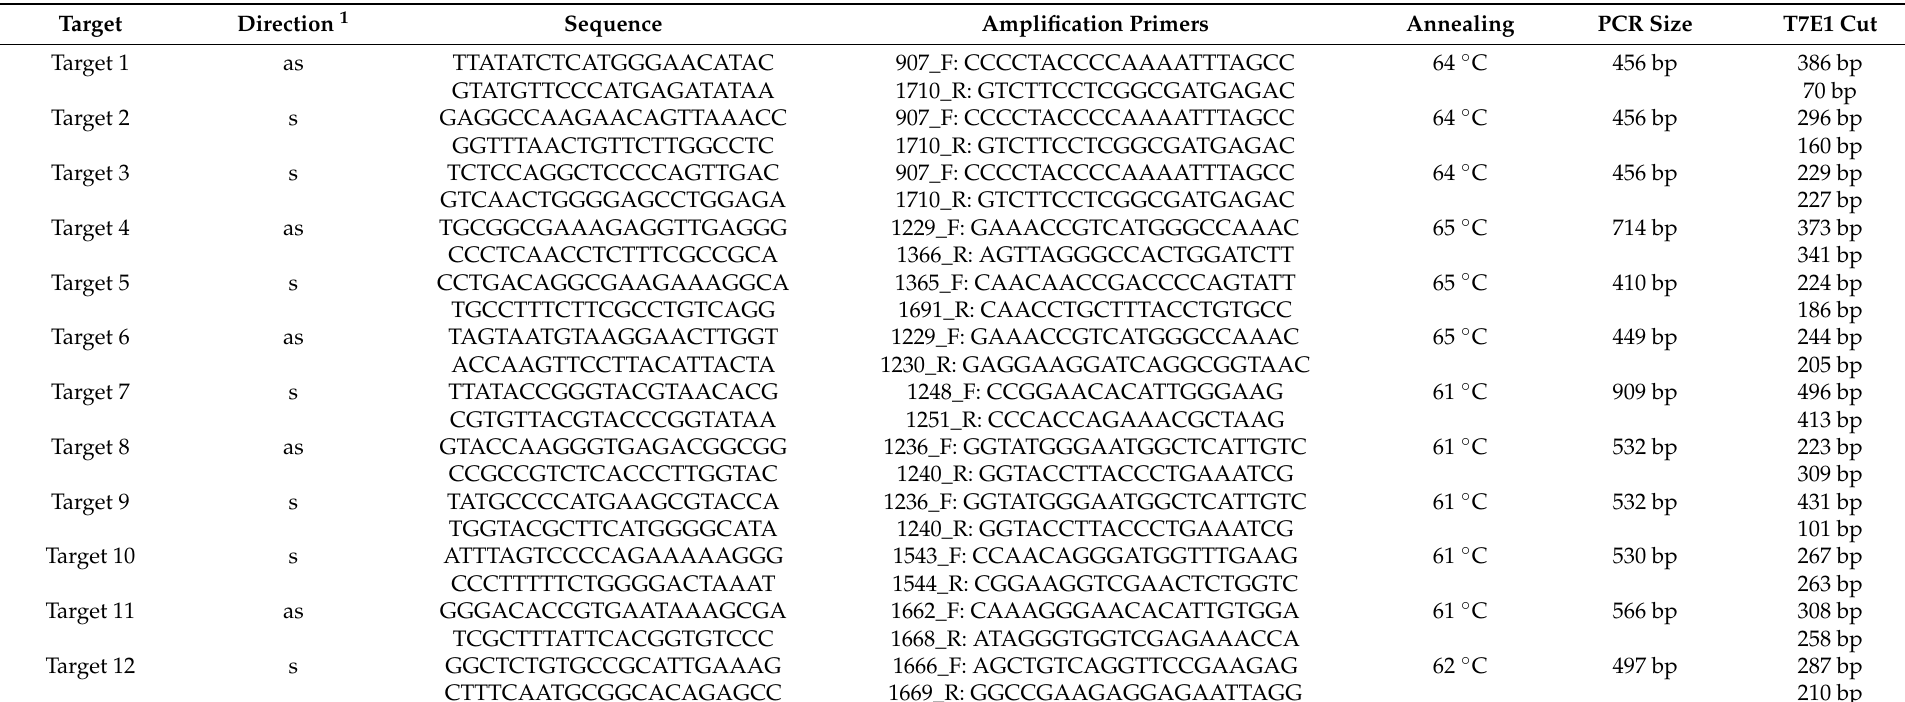
Table 1. Selected Sa Cas9 target sites, PCR primers and